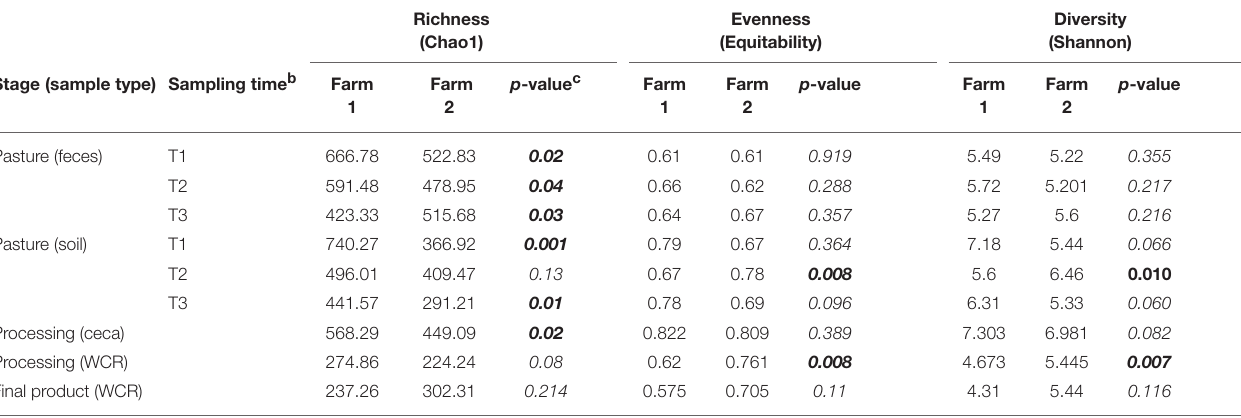
TABLE 2 | Comparison of α -diversity indices of microbiomes throughout the farm-to-fork continuum from two pastured poultry flocks a .